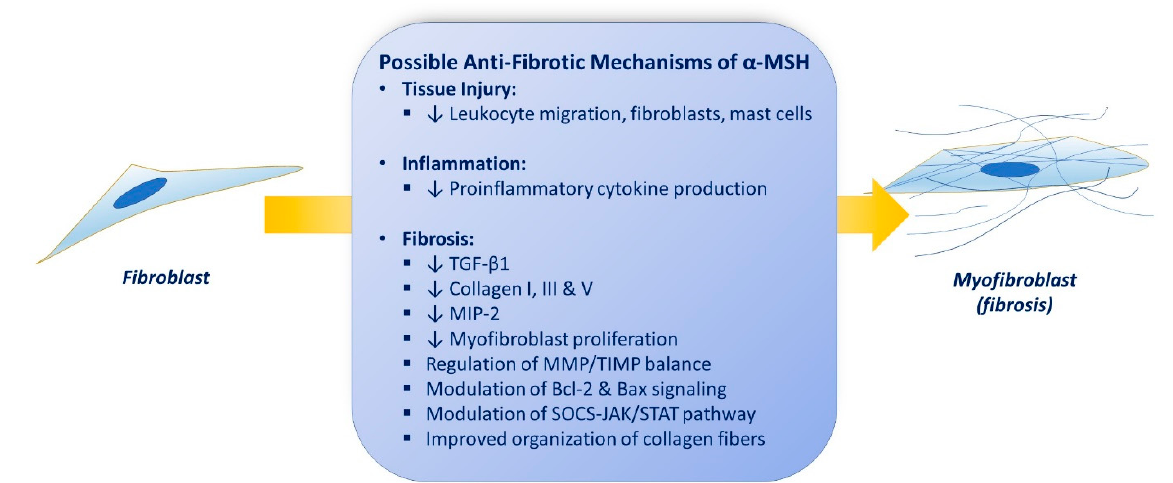
Figure 2. Possible anti-fibrotic properties of α -MSH (see text).